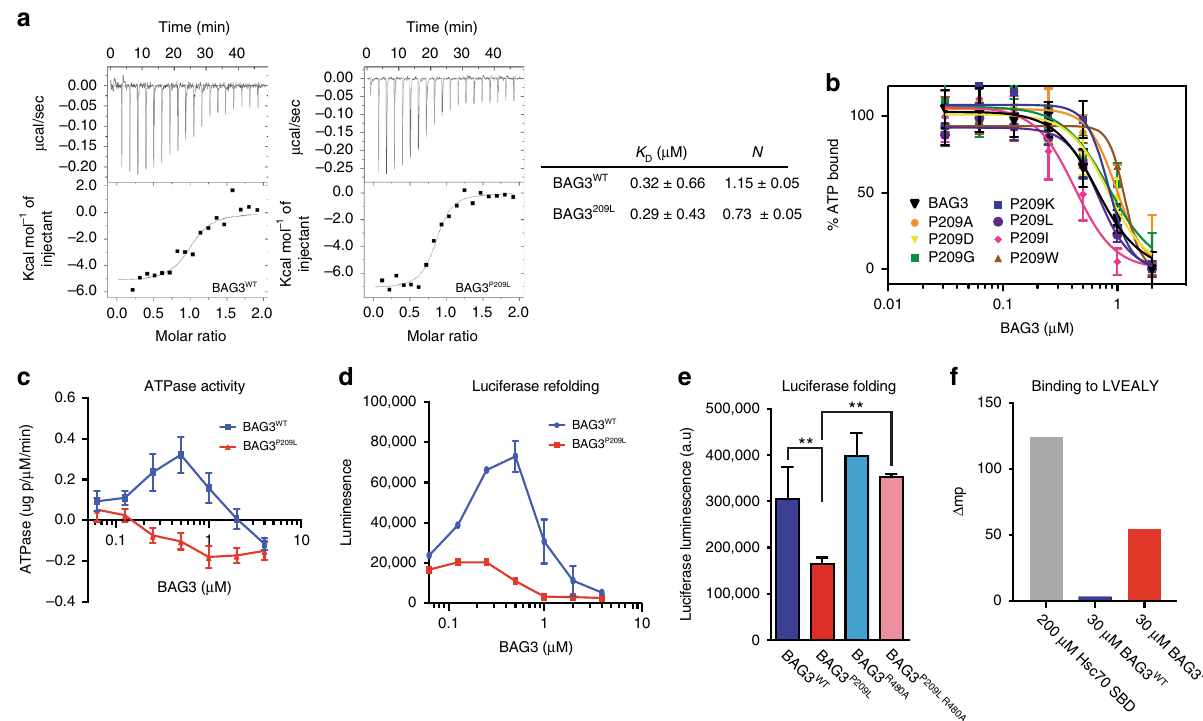
Fig. 4 BAG3 P209L fails to collaborate with Hsp70 in client refolding. a Recombinant BAG3 P209L and BAG3 wt have normal af fi nity to HSPA8 NBD . b All of the BAG3 variants are capable of releasing fl uorescent nucleotide from Hsc70/HSPA9. Results are the average of at least three experiments performed in triplicate. Error bars represent SD. See the methods for details. c , d Recombinant BAG3 P209L is not functional in promoting HSPA8 steady state ATP hydrolysis ( c ) and Hsp70-mediated refolding assays ( d ). Measurement of ATPase activity and denatured luciferase refolding was carried out in the presence of Hsc70, DnaJA2, and various concentrations of BAG3 WT or BAG3 P209L . Results are the average of at least three independent experiments performed in triplicate each. Error bars represent SD. e luciferase folding capacity of HEK293 cells expressing HSPB8 and BAG3 WT or indicated mutants of BAG3. Data represents the mean and standard deviation of two independent experiments (with three technical repeats for each experiment, Welch t test was used to calculate the P values, ** indicates P < 0.01). f Noncanonical interaction of BAG3 P209L with LVEAVY amyloid peptide. Source data are